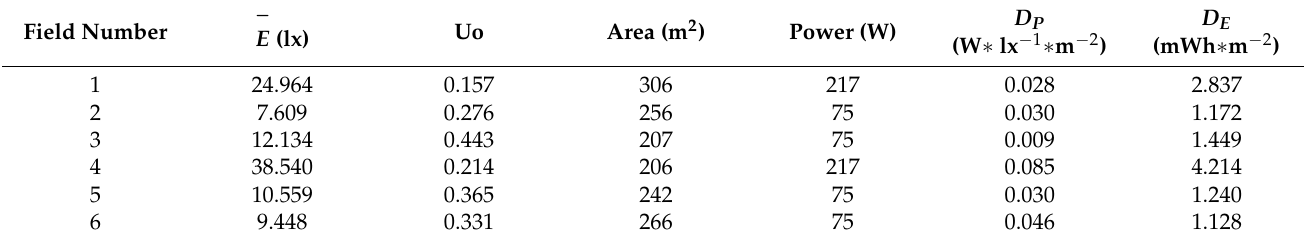
Table 4. Summary of calculation results of illuminance and energy indices of road lighting installation for 30 fields of Smocza